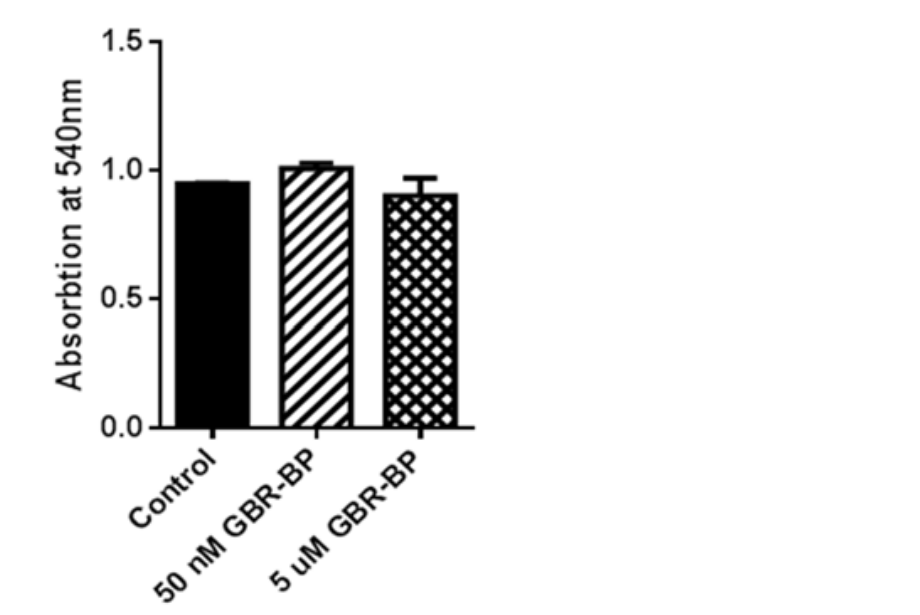
Figure 10. Optical density of formazan, a derivative of 3-(4,5-dimethyl-2-thiazolyl)2,5-diphenyl-2H- tetrazolium bromide, in LUHMES cells after 24-h incubation with GBR-BP at a concentration of 50 nM or 5 µ M and in the control (without GBR-BP). No significant differences were observed ( p > 0.05).